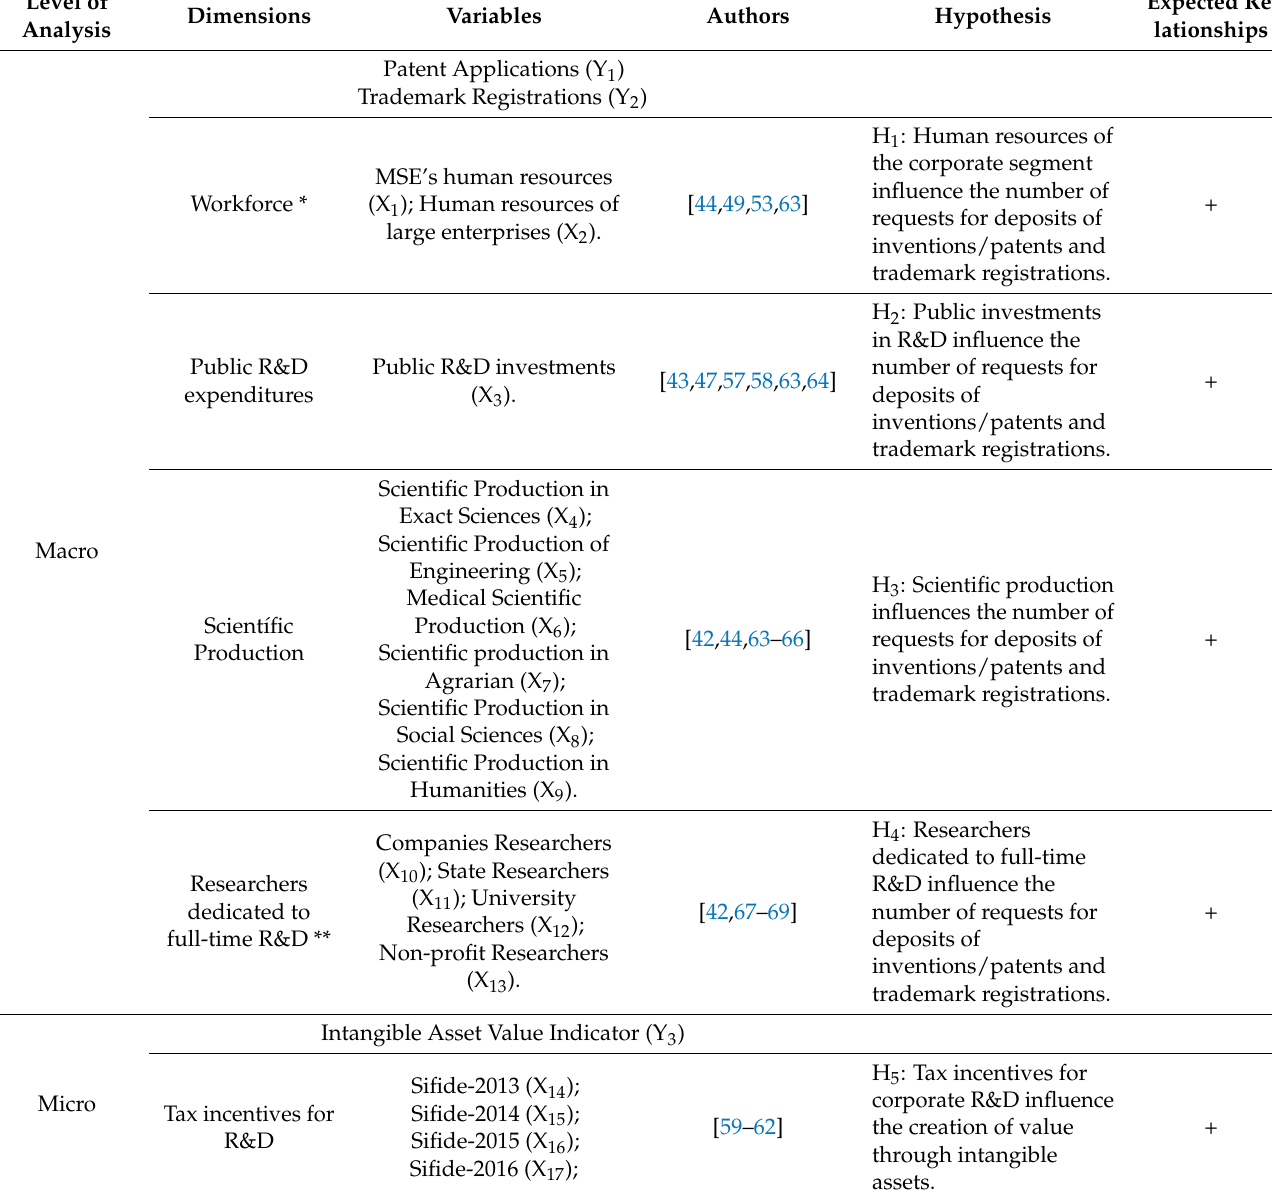
Table 1. Summary of Research Assumptions and Expected